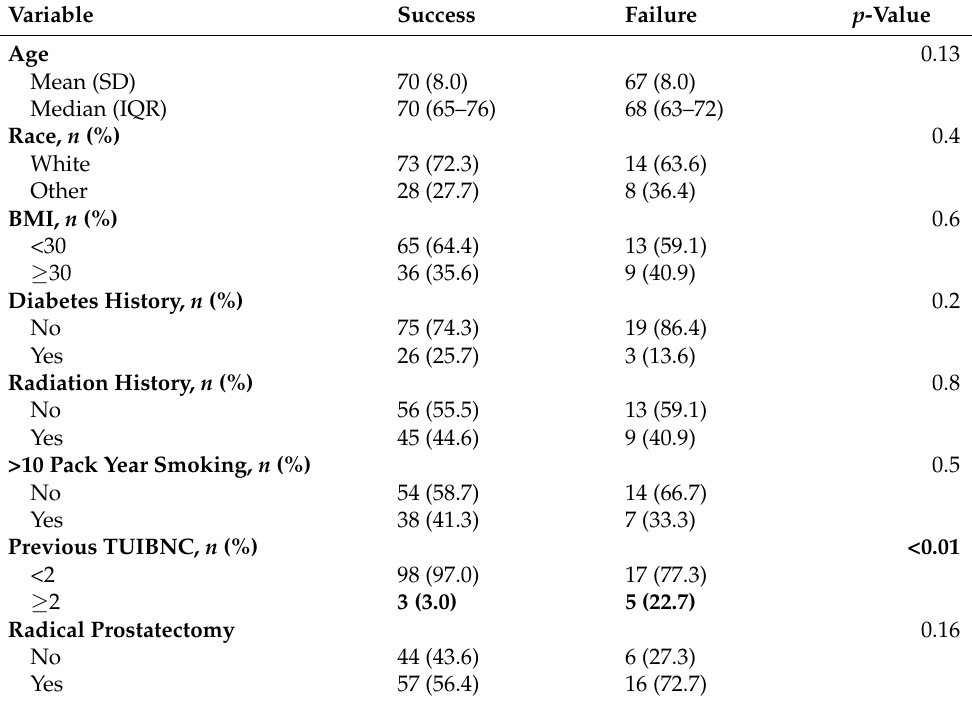
Table 1. Univariate analysis of TUIBNC success vs. failures.